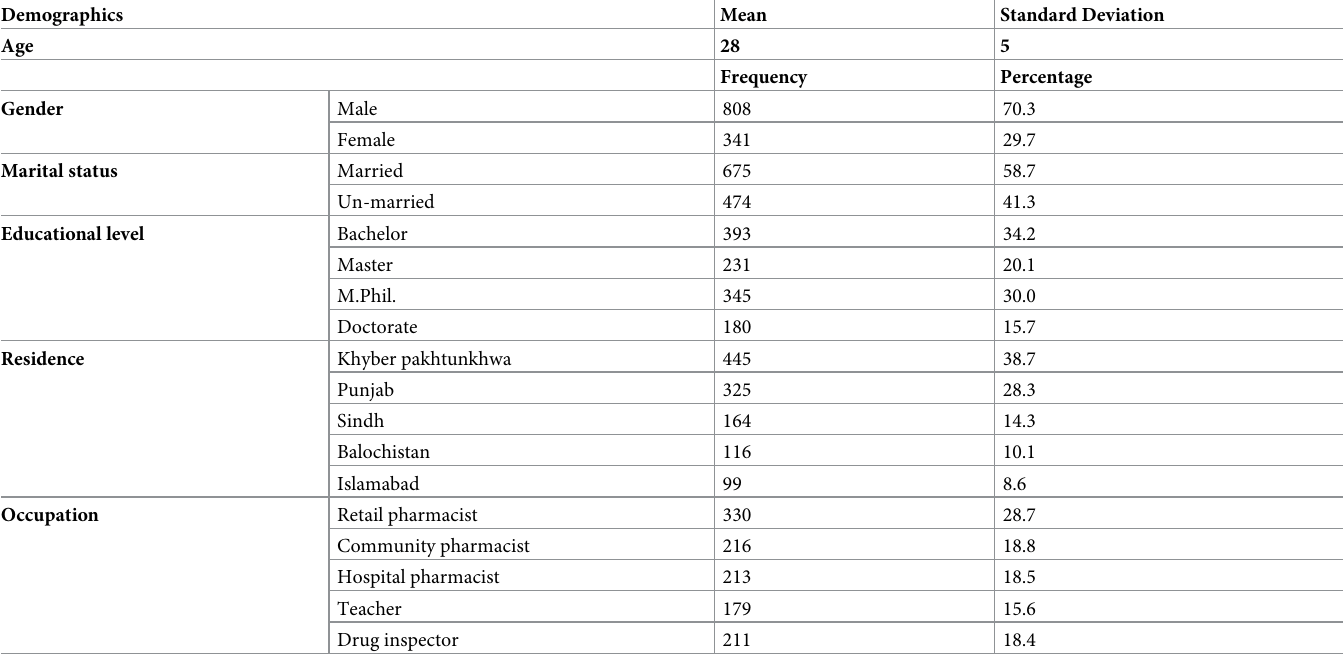
Table 1. Demographics characteristics of pharmacists (n =